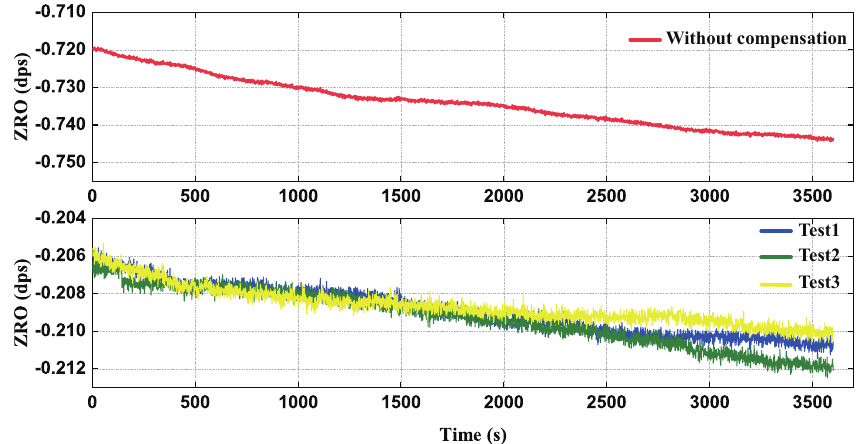
Figure 16. The ZRO of gyroscope at room temperature before and after compensation.